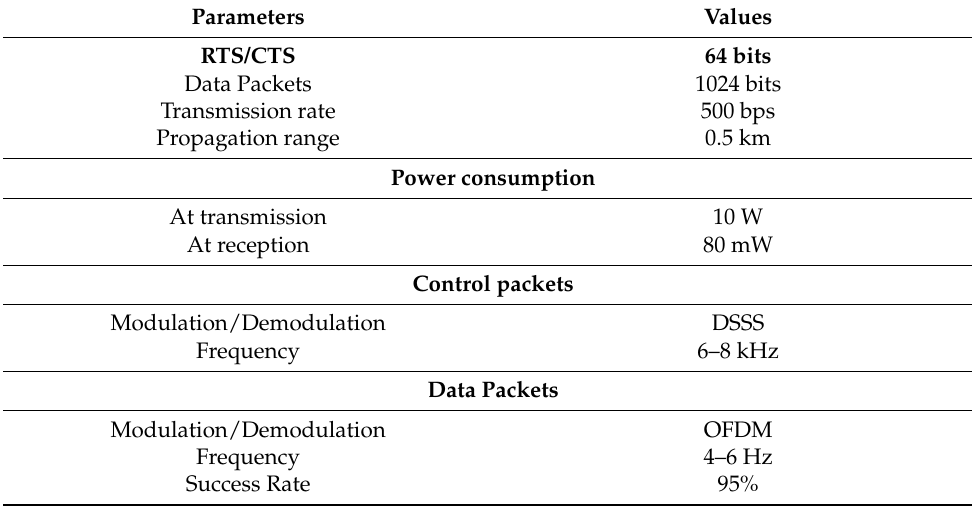
Table 4. Simulation parameters taken by the FD-DA-CSMA